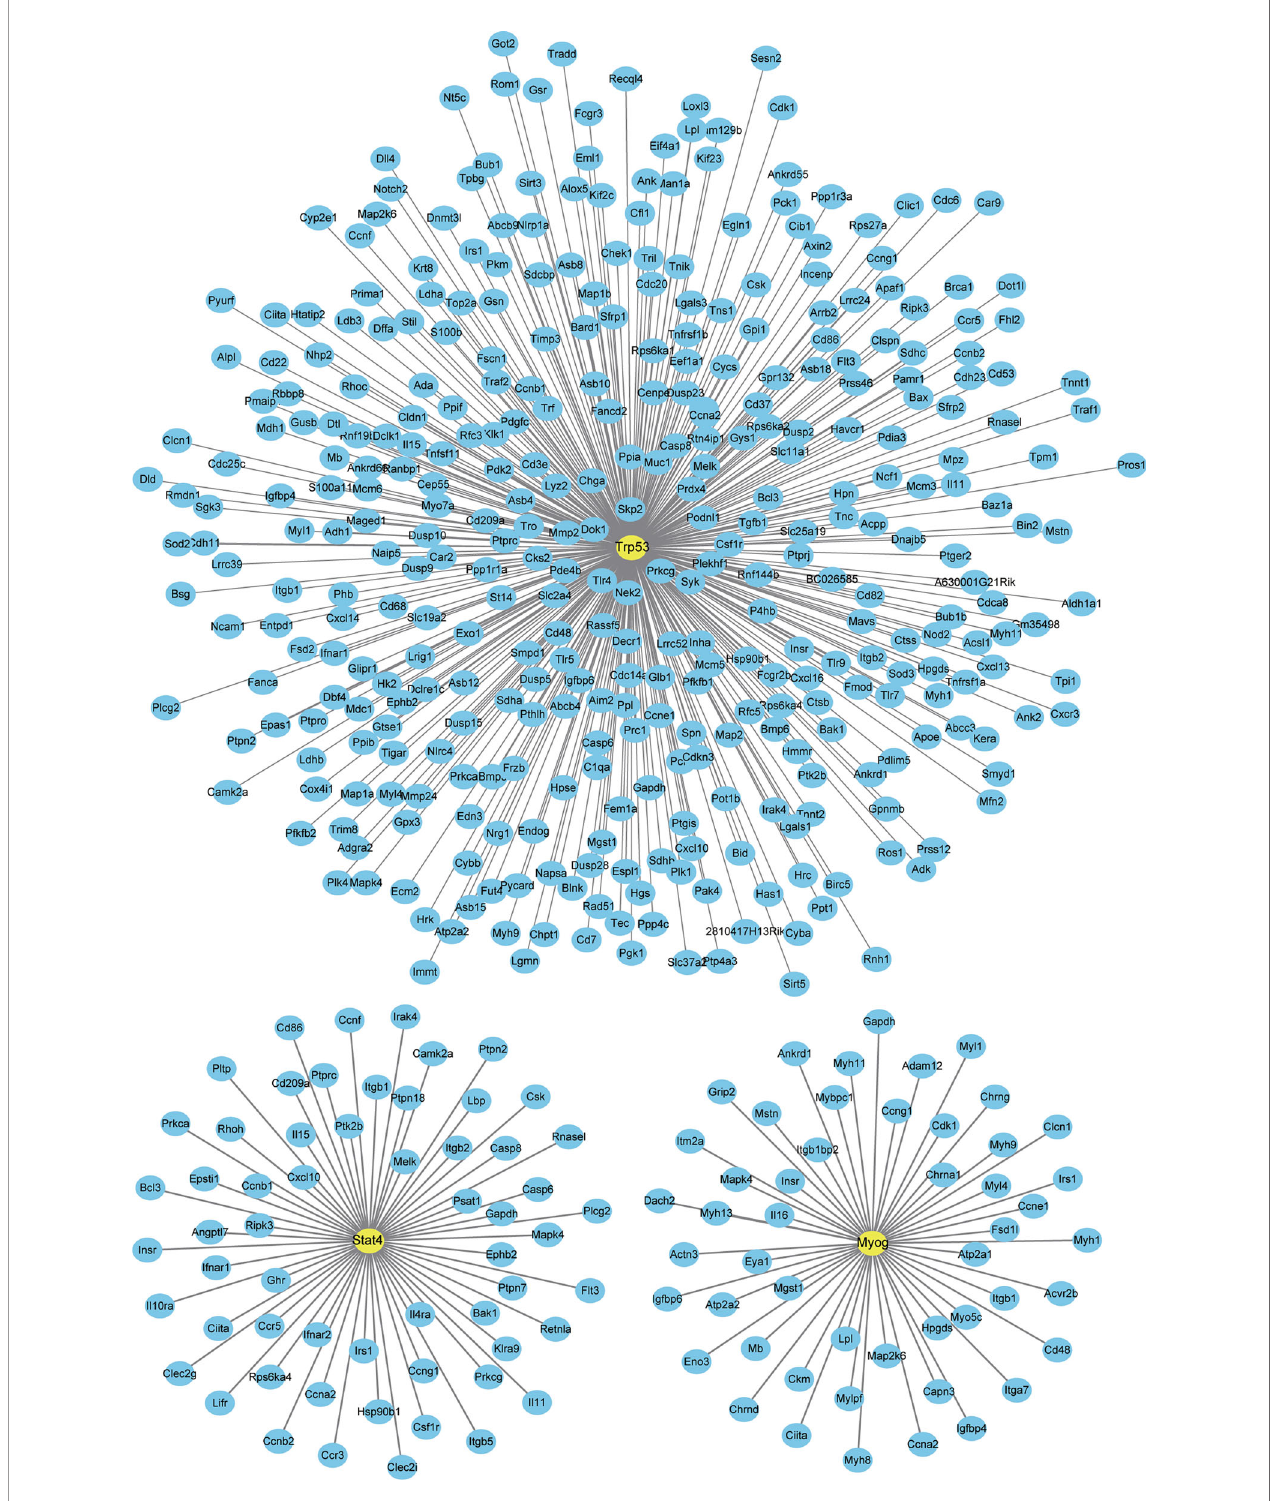
FIGURE 8 | Interaction between newly discovered differentially expressed genes (DEGs) and differentially expressed transcription factors (DETFs) after three days of interleukin-6 (IL-6) infusion. All the newly discovered DEGs and DETFs after three days of IL-6 infusion are integrated and analyzed. The three representative transcription factors (TFs) marked can interact strongly with IL-6 or have been reported to be related to skeletal muscle atrophy. Only TFs and DEGs with a score > 200 for the interaction are